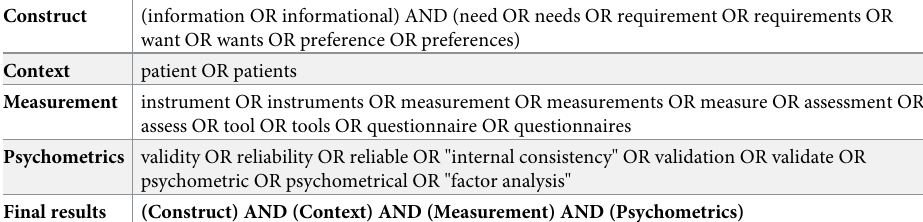
Table 1. Search strategy for electronic database search.